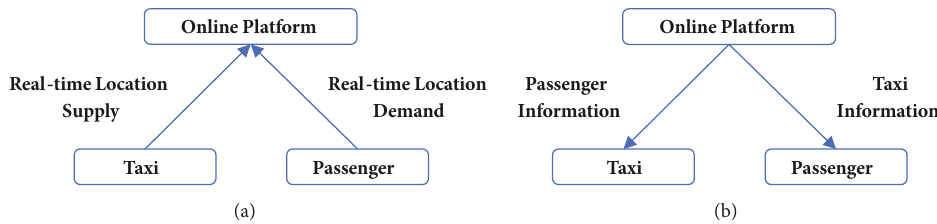
Figure 2: Information exchange design. (a) Information flows in online platform. (b) Information flows out from online platform.